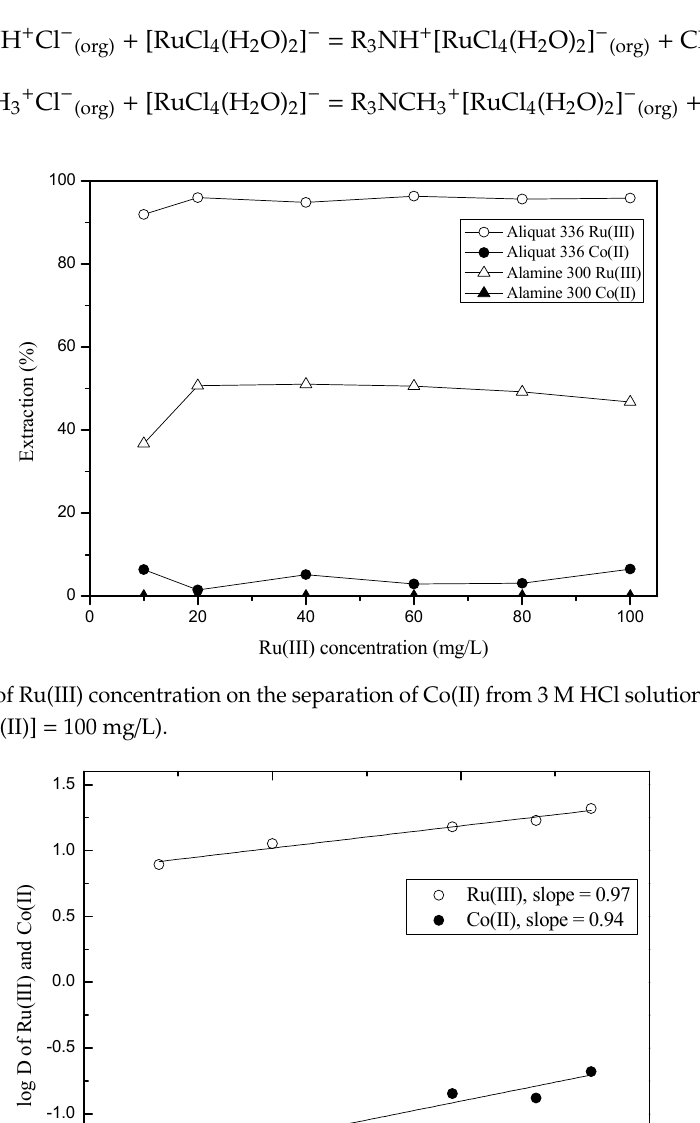
Figure 3. Plot of log [Aliquat 336] vs. log D of Ru(III) and Co(II) from 3 M HCl solution. ([Ru(III)] = 10 mg/L and [Co(II)] =100 mg/L).